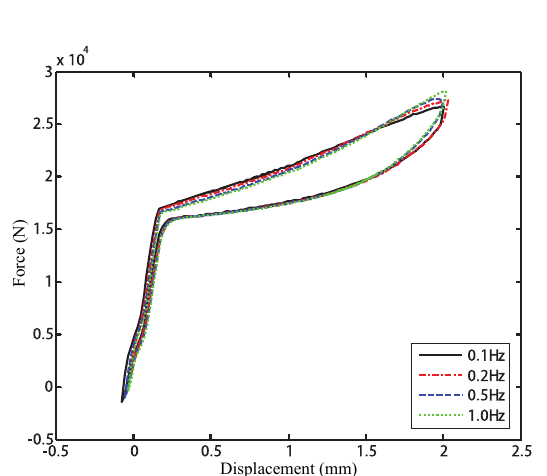
Fig. 3. Hysteresis curves under different excitation conditions.